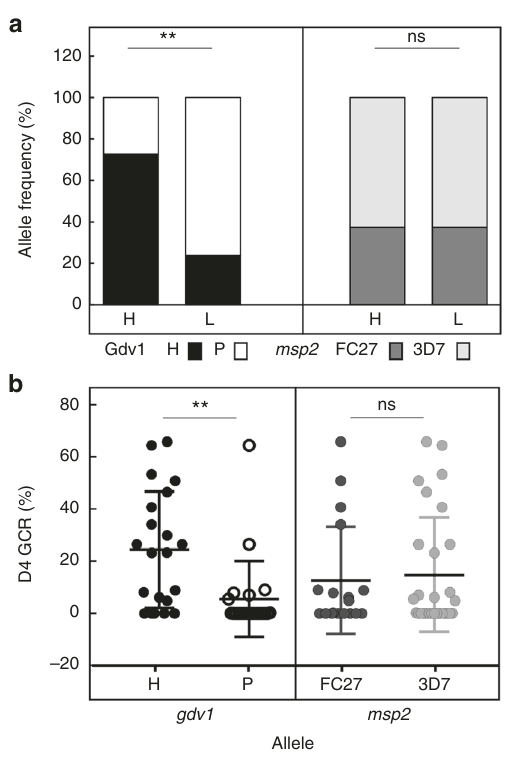
Fig. 10 GDV1 allele H 217 is over represented in high GCR patient samples. a The frequency of the gdv1 alleles encoding H (black) and P (white) or (B) msp2 FC27 (dark grey) and 3D7 (light grey) family alleles in the high (H) ( n = 20) and low (L) GCR ( n = 19) samples are plotted. Signi fi cance was assessed using a Fisher Exact test. b The D4 GCR (%) of each of the samples with gdv1 allele H 217 (H, black dot) or P 217 (P, open circle) or msp2 allele FC27 (dark grey dot) or 3D7 (light grey dot) is plotted with the mean and s.d. indicated. The Kruskal – Wallis test followed a Dunn ’ s multiple comparison test was used to compare the D4 GCR of the samples with distinct gdv1 or msp2 alleles (Prism GraphPad v7.05). Probability is indicated, p > 0.05 (ns) and p ≤